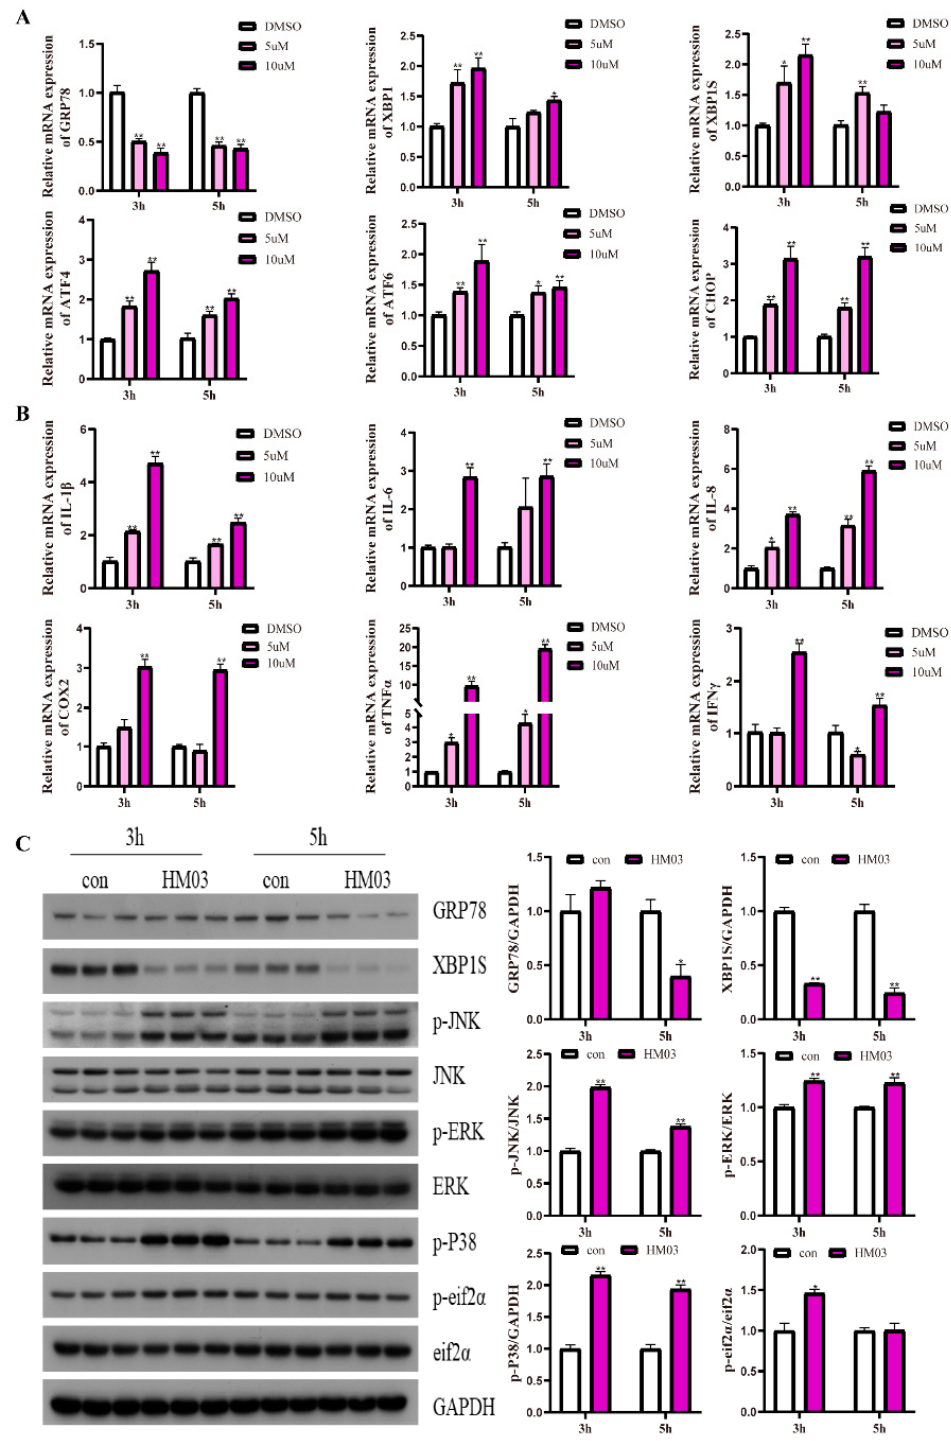
Figure 3. Effects of GRP78 inhibitor (HM03) treatment on ER stress and inflammation in macrophages of large yellow croakers. ( A ) Relative mRNA expression of ER stress-related genes after HM03 treatment for 3 h and 5 h with different concentrations. ( B ) Relative mRNA expression of inflammatory genes after HM03 treatment for 3 h and 5 h with different concentrations. ( C ) Protein levels of ER stress-related proteins and inflammatory-related proteins after 10 µ M HM03 treatment for 3 h and 5 h. Values are presented as mean ± SEM ( n = 3). * Significant difference ( p < 0.05); ** highly significant difference ( p < 0.01).